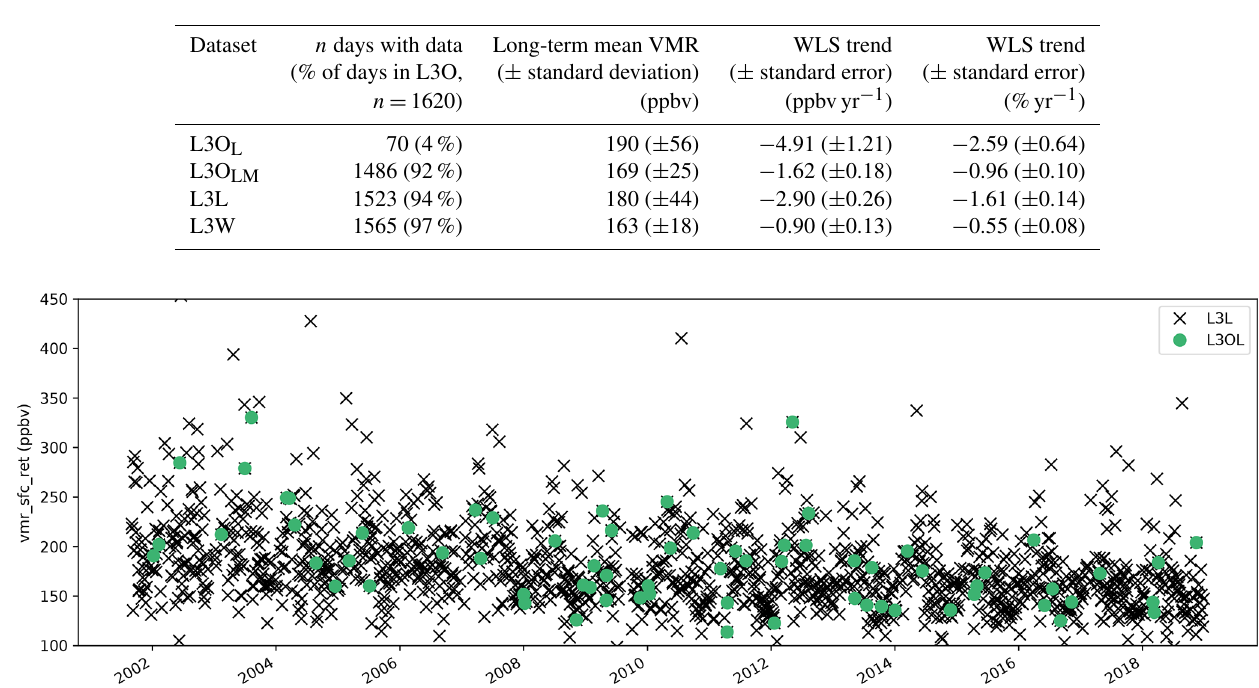
Figure 8. L3L (black crosses) and L3O L (green circles) time series for the entire study period. Note that the size of the plotted symbol required to visualise the whole time series artificially exaggerates the sense of temporal coverage; in reality, L3L is only present on 25% of the days across the study period and L3O L on just